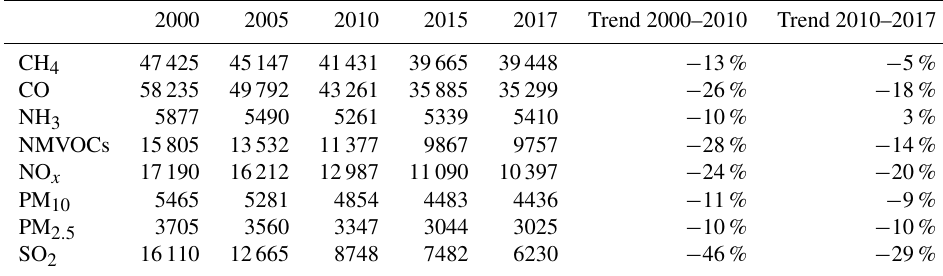
Table 2. Emissions for selected years for all pollutants (sum of all countries and sectors, given in kilotonnes) and the trend in emissions between 2000 and 2010 and between 2010 and